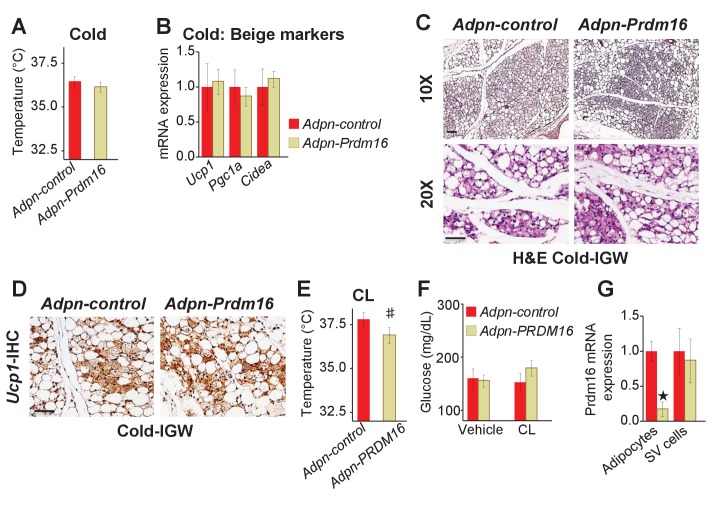
White adipocyte necessity tests for cold and Adrb3 induced beiging.(A) Rectal temperature from two-month-old cold-exposed Adpn-control and Adpn-Prdm16 mutant male mice (n = 10/group). (B) mRNA expression of beige and thermogenic genes from cold-exposed mice described (C) (n = 6/group in triplicate). (C) Representative H&E staining of IGW depot sections from cold-exposed mice taken at 10x and 20x magnification. Scale bar = 100 µm. (D) Representative Ucp1 IHC staining of IGW depot sections from cold-exposed mice. Scale bar = 100 µm. (E) Rectal temperatures from two-month-old Adpn-control and Adpn-Prdm16 mutant male mice after CL treatment (n = 10/group). ♯p<0.001 unpaired t-test, two tailed: CL-treated mutant compared to CL-treated control mice. (F) Sera glucose from Adpn-control and Adpn-Prdm16 mutant mice described in (E). (G) mRNA expression of Prdm16 from isolated floated adipocytes and SV cells generated from Adpn-control and Adpn-Prdm16 mutant mice (n = 4/group). ★p<0.001 unpaired t-test, two tailed: control compared to mutant. All data are means ± SEM.